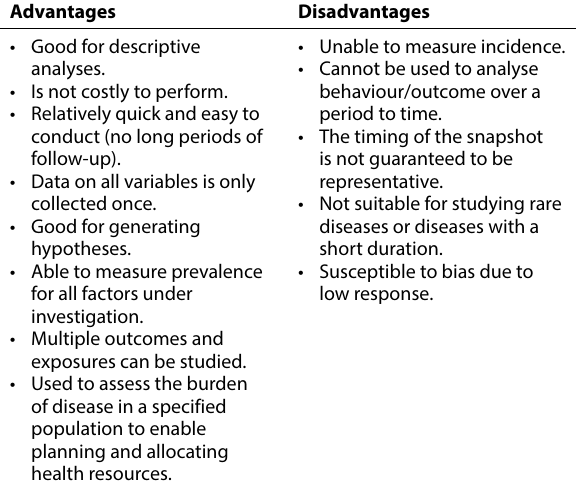
Table 1: Advantages and disadvantages of descriptive